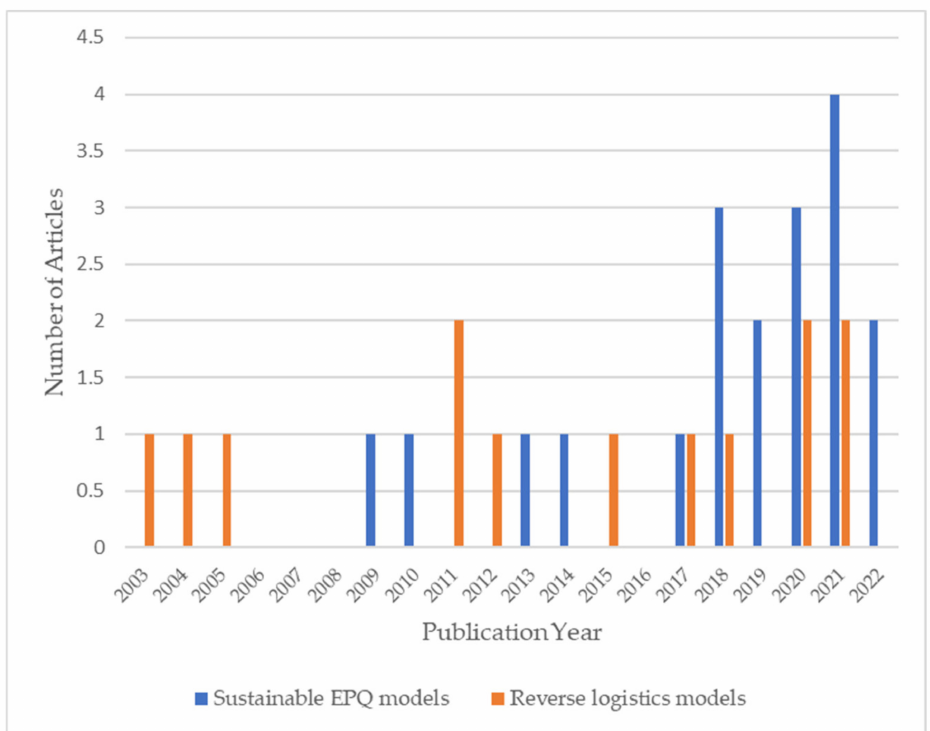
Figure 2. Number of articles per